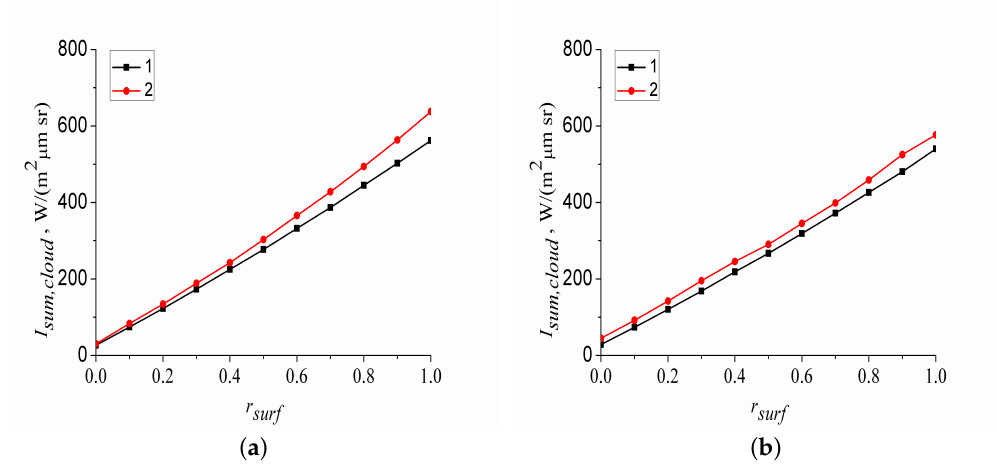
Figure 3. Radiation intensity I sum , cloud as a function of the reflectance r surf . ( a ) λ = 0.55 µ m, θ sun = 0 ◦ , (Figure 2), and curve 2 is for averaging over an ensemble of random paraboloid